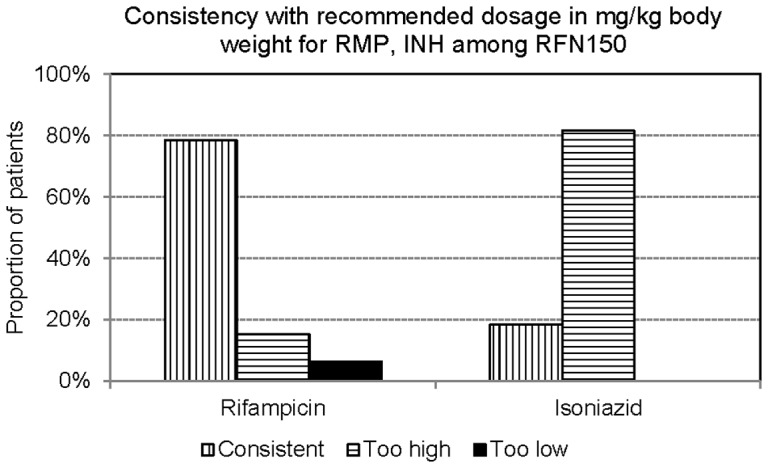
Consistency with recommended dosage in mg/kg body weight for Rifampicin 8–10 mg/kg) and Isoniazid (4–6 mg/kg) among those prescribed Rifinah150.